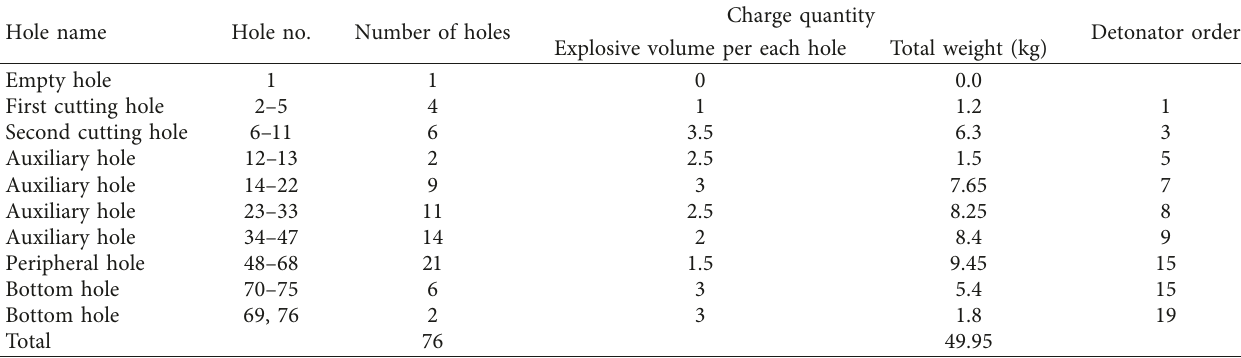
Table 3: Blasting parameters after